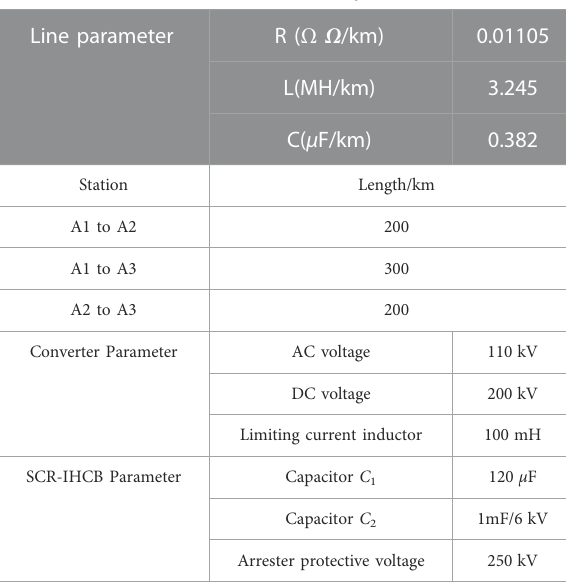
TABLE 2 Parameter of three-terminal HVDC